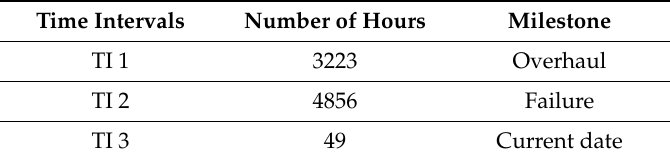
Table 7. Time intervals analyzed in our